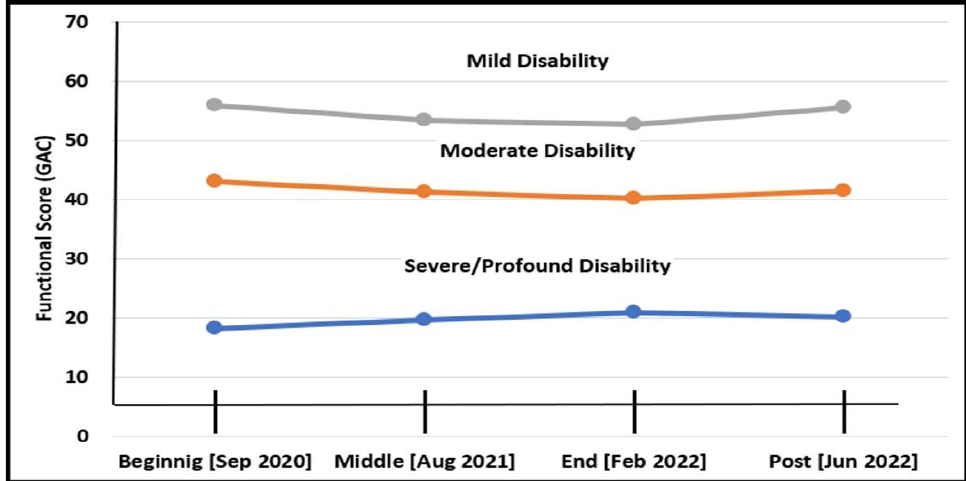
Figure 2. Functional changes for three groups of ID (September 2020 – end of June 2022).